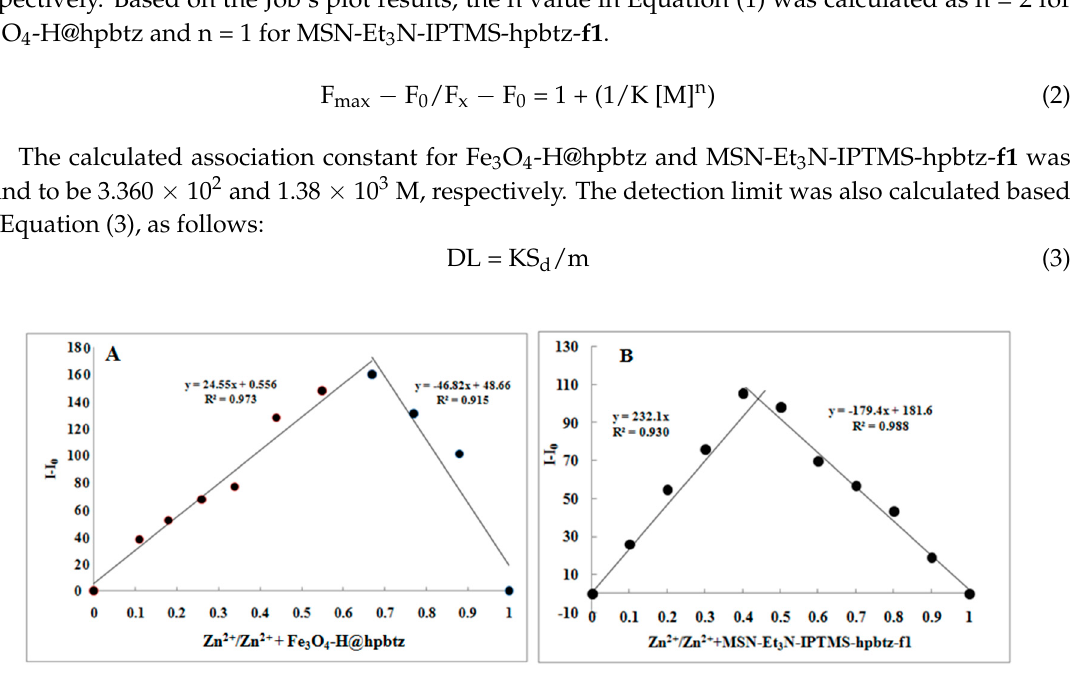
Figure 13. Fluorescence emission spectra for ( A ) Fe 3 O 4 -H@hpbtz in the presence of 7.8 equivalent, 300 µL and ( B ) MSN-Et 3 N-IPTMS-hpbtz- f1 in the presence of 15.4 equivalent, 350 µL of various metal ions at λ = 350 and 305 nm, respectively, in ethanol.